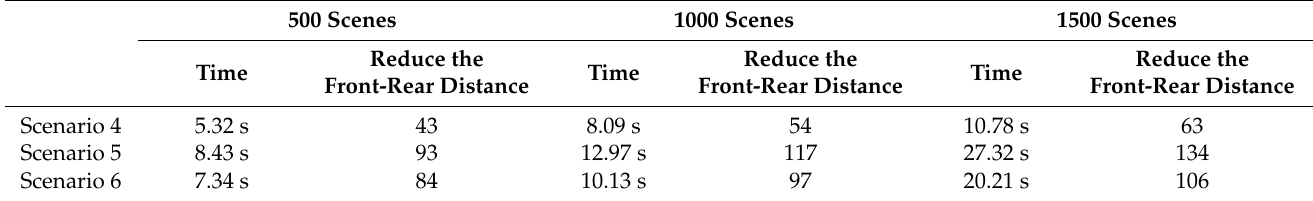
Table 2. Operating costs and carbon emission of different scenarios.